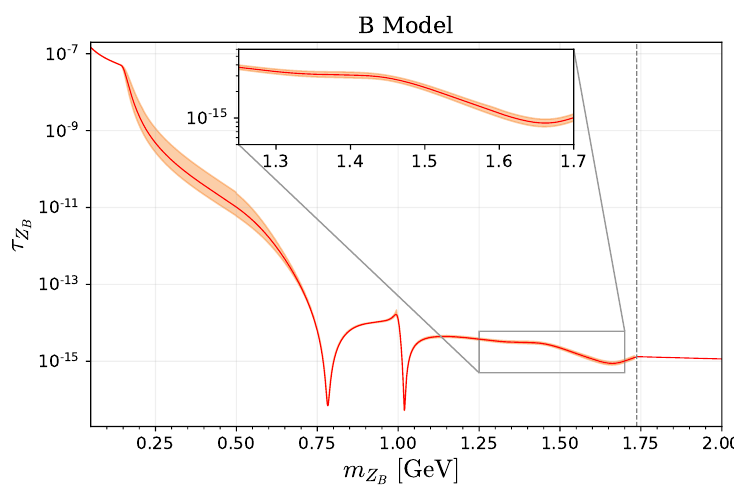
Figure 4 . Uncertainty on the Z B mediator lifetime obtained by propagating the cross-section fit envelopes into the hadronic width computation. The red curve is the Z lifetime evaluated B by considering the best fit parameters for each hadronic channel width, while the orange region represents the envelope lifetime uncertainty estimate. The large uncertainties below ∼ 0 . 6 GeV are caused by the lack of πγ experimental data in this region. For the regions where data is available, the uncertainties always stay below the 10% level, as we can see in the zoomed in plot. We considered g B = 10 − 4 for the lifetime calculation, we remark, however, that the mediator coupling does not affect the uncertainties. The vertical dashed grey line indicates the hadron-quark